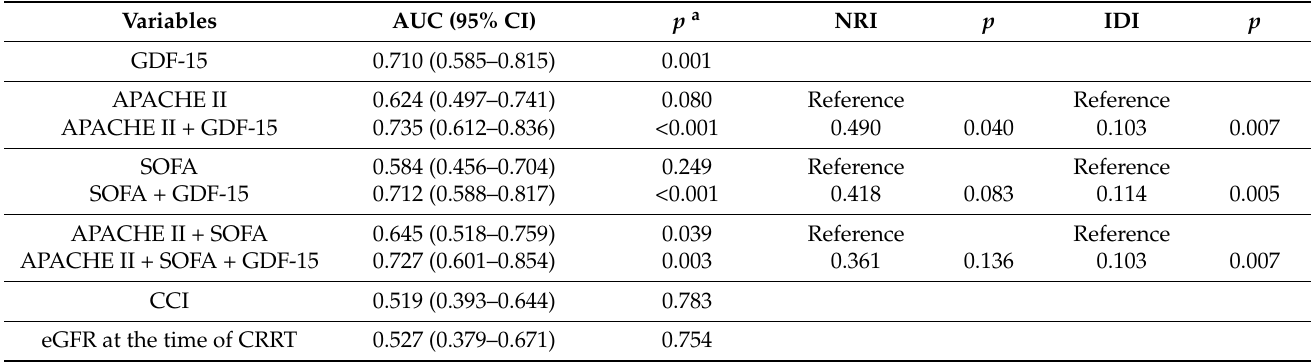
Table 3. Comparison of AUC and predictive power of prognosis predictors for in-hospital mortality. Variables